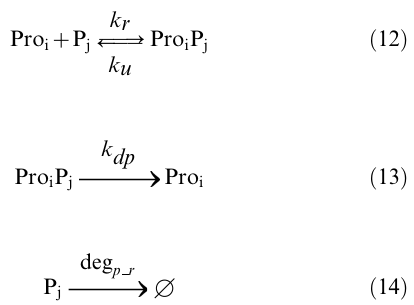
PLoS Computational Biology |